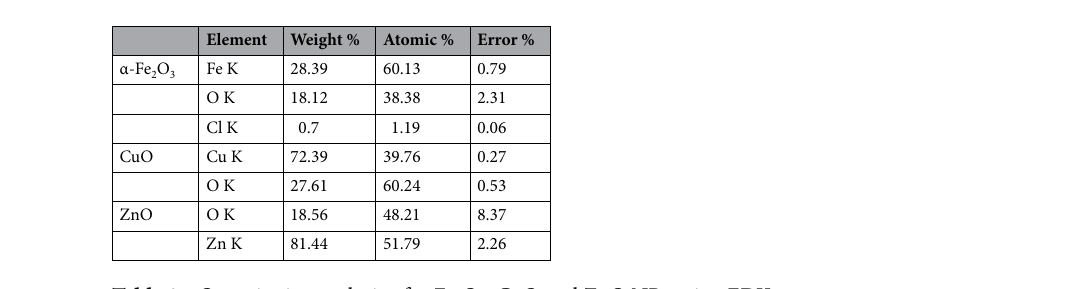
Table 2. Quantitative analysis of α-Fe 2 O 3 , CuO and ZnO NPs using